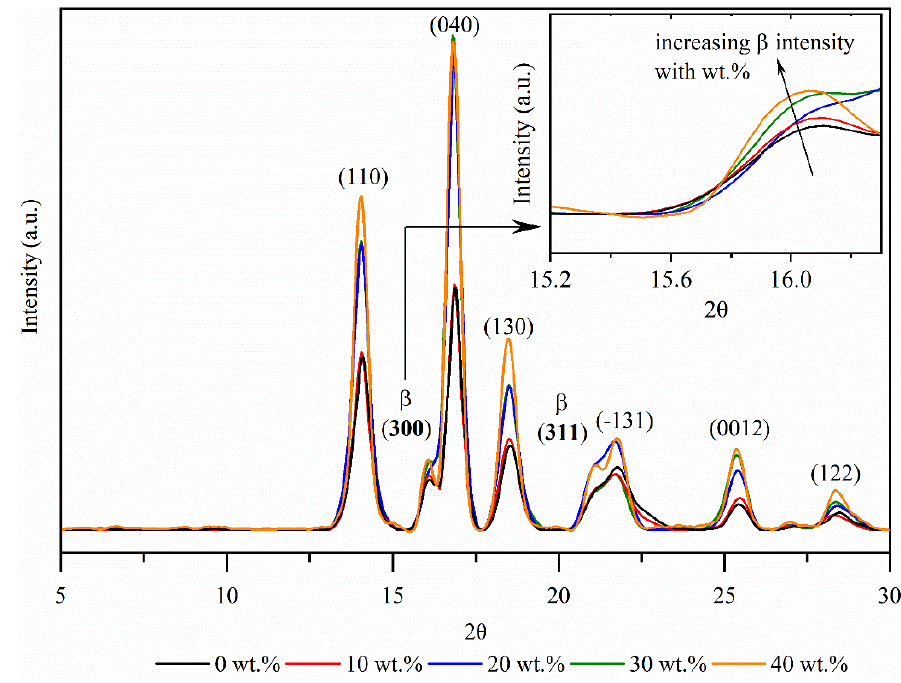
Figure 5. X-ray diffraction (XRD) spectra of the composites with a neat (NPP) matrix. The XRD results show that the matrix NPP material (0 wt.%) is isotactic, where the chains are packed into the lattice as a left- or right-handed 2*3 1 helical conformation with methyl groups facing up or down [46,56]. This tacticity enables the formation of polymor- phic α, β, and γ -phases.